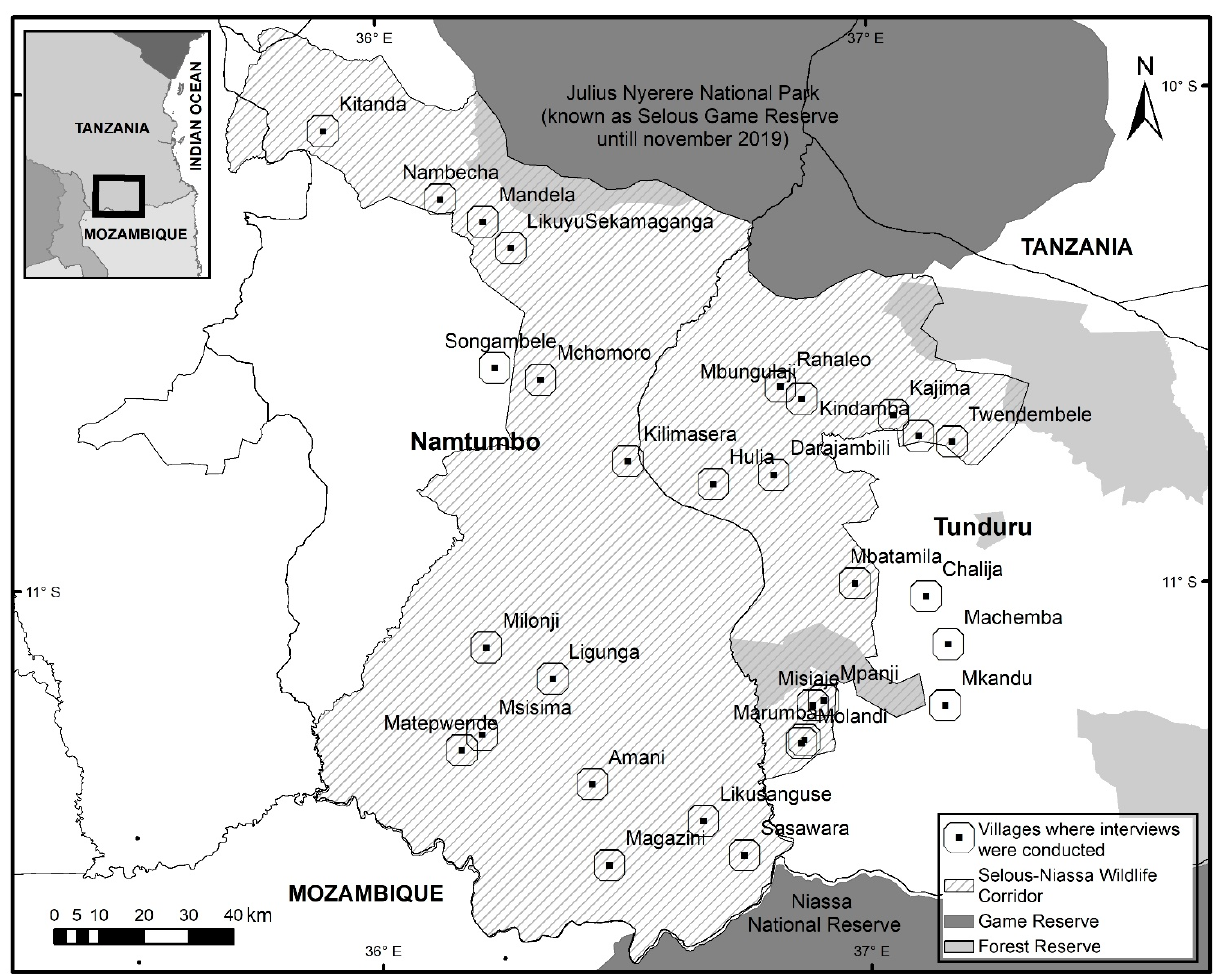
Figure 1. Selous-Niassa Wildlife Corridor map and location of villages where interviews were con-